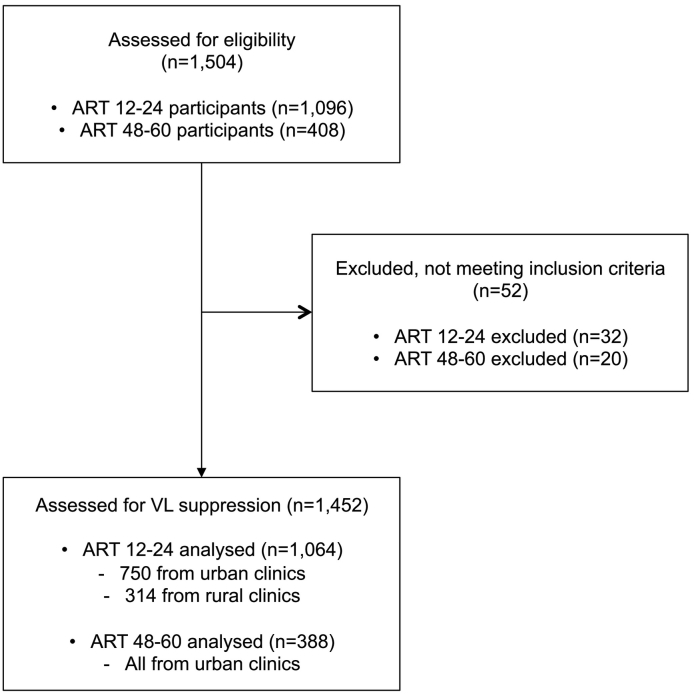
Flow chart of participants in the study. ART 12–24 represents participants on ART for 12 to 24 months. ART 48–60 represents participants on ART for 48 to 60 months.